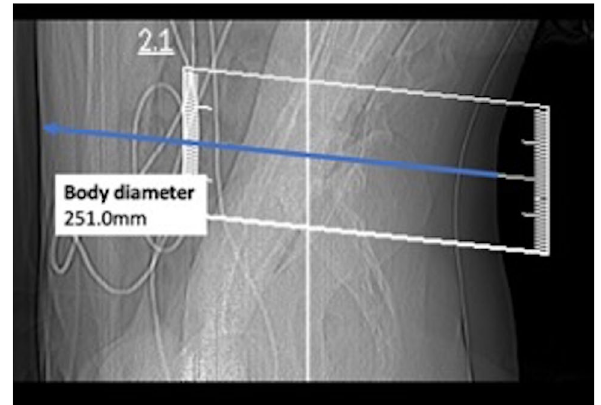
Figure 1. Lateral scout obtained for a planned lumbar intervertebral disc biopsy in a 47-year-old woman with suspected spondylodiscitis at level L4/5. The blue line indicates the antero-posterior body diameter (251.0 mm).